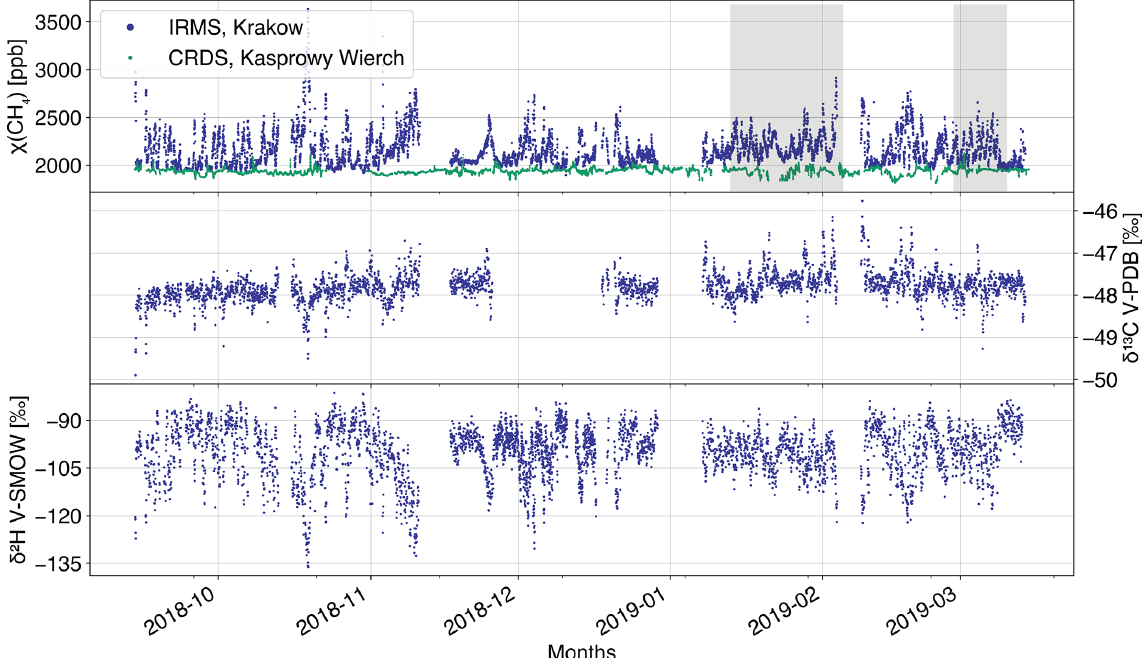
Figure 2. Time series of the observed χ (CH 4 ) ( n = 7886), δ 13 C ( n = 3477), and δ 2 H ( n = 4389), together with the χ (CH 4 ) time series observed at Kasprowy Wierch (green; n = 21028). The shaded areas show when there was a mismatch between the IRMS and CRDS instruments in the mole